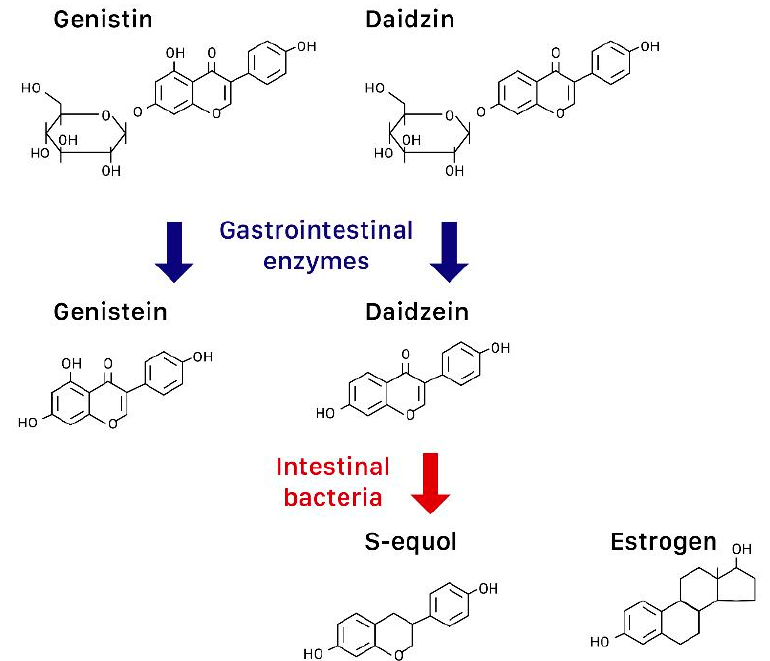
Figure 1. The chemical structures of genistein and its precursor genistin, daidzein and its precursor daidzin, s-equol, and estrogen.